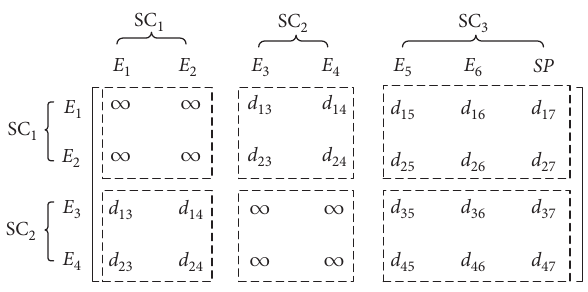
Figure 12: Subloop merging matrix with three